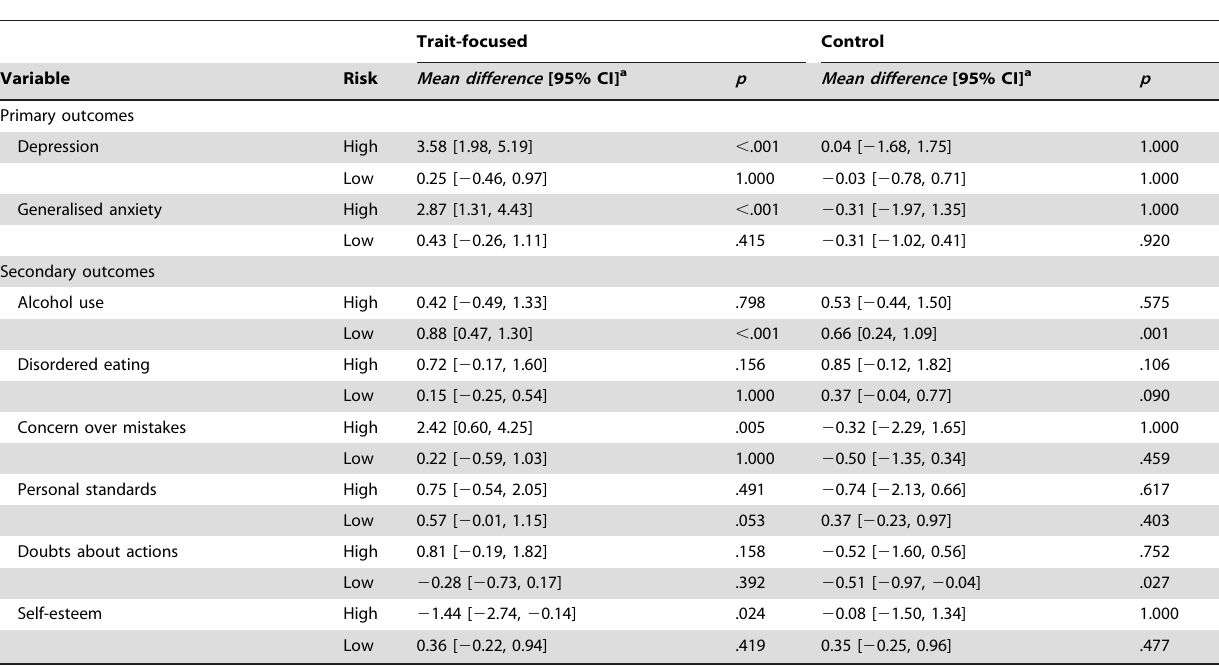
Table 5. Analysis of contrasts between baseline and 12-week